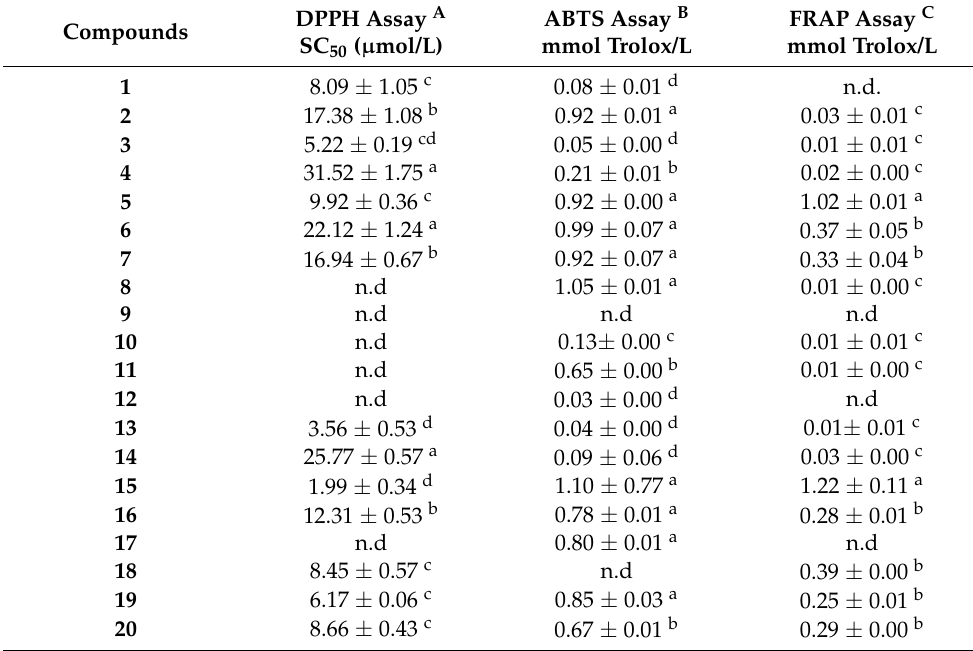
Figure 2. The scavenging effects of T. grandis methanolic extract and fractions on DPPH free radicals. ( a ) Log concentration–scavenging rate fitting curve of ascorbic acid. ( b ) Log concentration–scavenging rate fitting curve of ME. ( c ) Log concentration–scavenging rate fitting curve of PEE. ( d ) Log concentration–scavenging rate fitting curve of EAE. ( e ) Log concentration–scavenging rate fitting curve of NBE. ( f ) Log concentration–scavenging rate fitting curve of WF. All values are mean ± SD from three independent experiments. ME: methanolic extract, PEE: petroleum ether extract, EAE: EtOAc extract, NBE: n-BuOH extract and WE: water extract. Table 2. Antioxidant activities of compounds 1 – 23 from T. grandis .